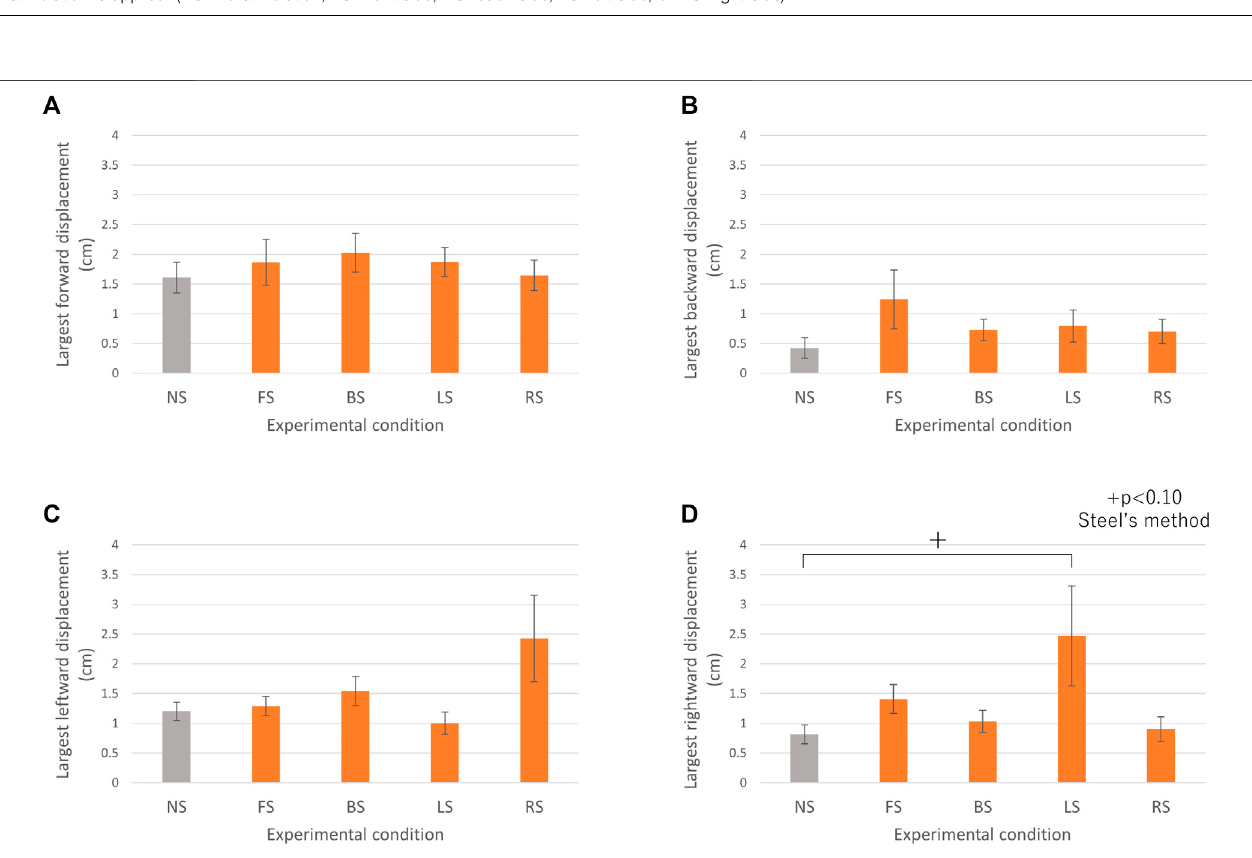
FIGURE 10 | Largest displacement of head position from the initial position: (A) Forward displacement, (B) Backward displacement, (C) Leftward displacement, (D) Rightward displacement (NS: No stimulation, FS: front side, BS: back side, LS: left side, or RS: right side).